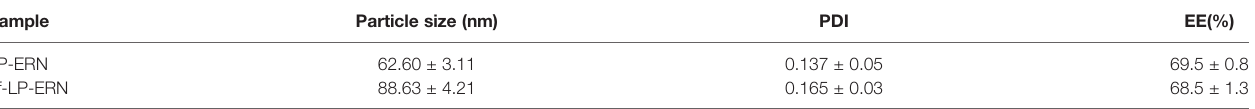
TABLE 1 | Characterization of LP-ERN and Tf-LP-ERN properties. Sample